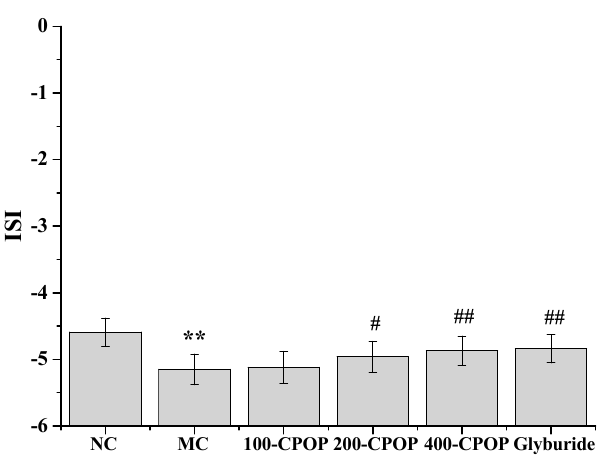
Figure 5. Effect of CPOP on Insulin Sensitivity Index (ISI) in STZ-induced diabetic rats. ** p < 0.01 vs. NC group ( N = 8); # p < 0.05, ## p < 0.01 vs. MC group ( N = 8). NC is the normal control group; MC is the